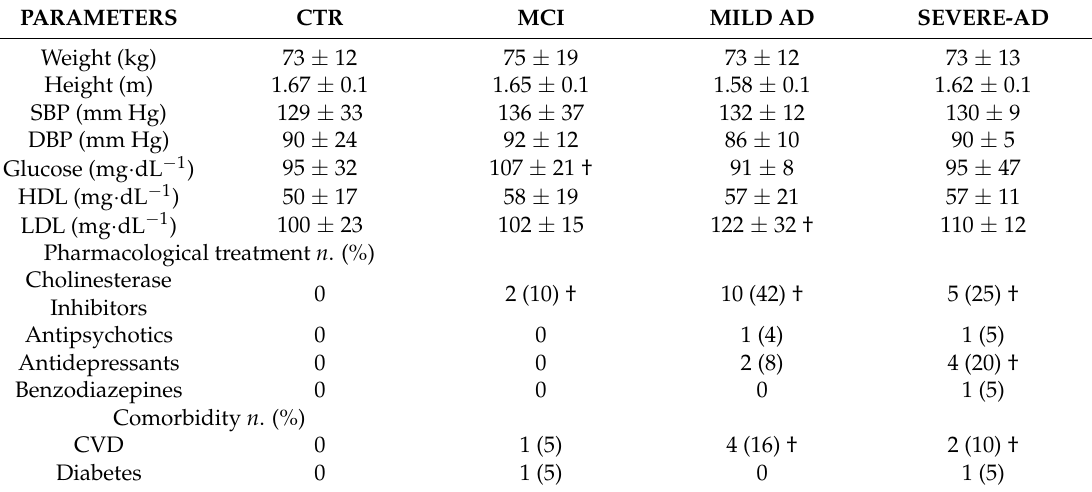
Table 1. Clinical characteristics of the study